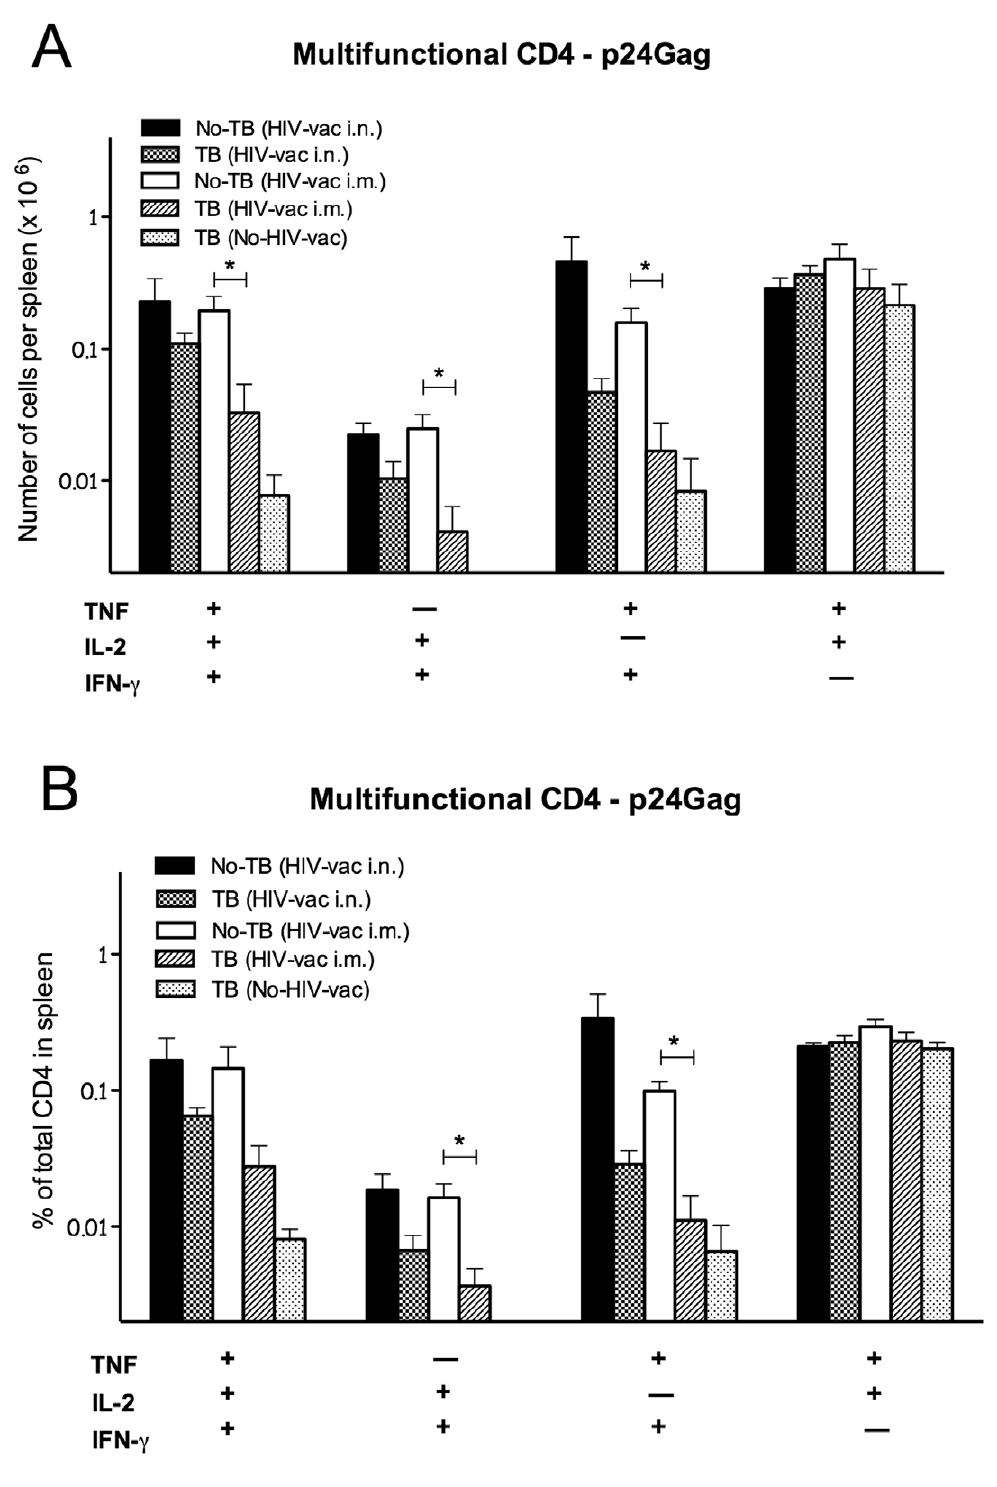
Figure 6. Multifunctional HIV p24 antigen-specific T cells in spleens of uninfected or Mtb -infected mice vaccinated with MultiHIV DNA/protein. Splenocytes from Mtb -infected or uninfected mice, subsequently immunized and boosted with MultiHIV DNA/protein, were isolated 4 wk post-vaccination, restimulated ex vivo with HIV p24 antigen, and stained for CD4 markers and for intracellular IFN- c , TNF, and IL-2 (details in Materials and Methods). Frequencies of HIV p24 antigen-specific multifunctional CD4 T cells simultaneously producing IFN- c , IL-2 and TNF were determined by flow cytometry. Mean numbers (A) and frequencies (B) 6 SEM of multifunctional T cells are shown (6–8 animals/group from one individual experiment; *: P , 0.05). The presence of multifunctional T cells was examined in two separate experiments.